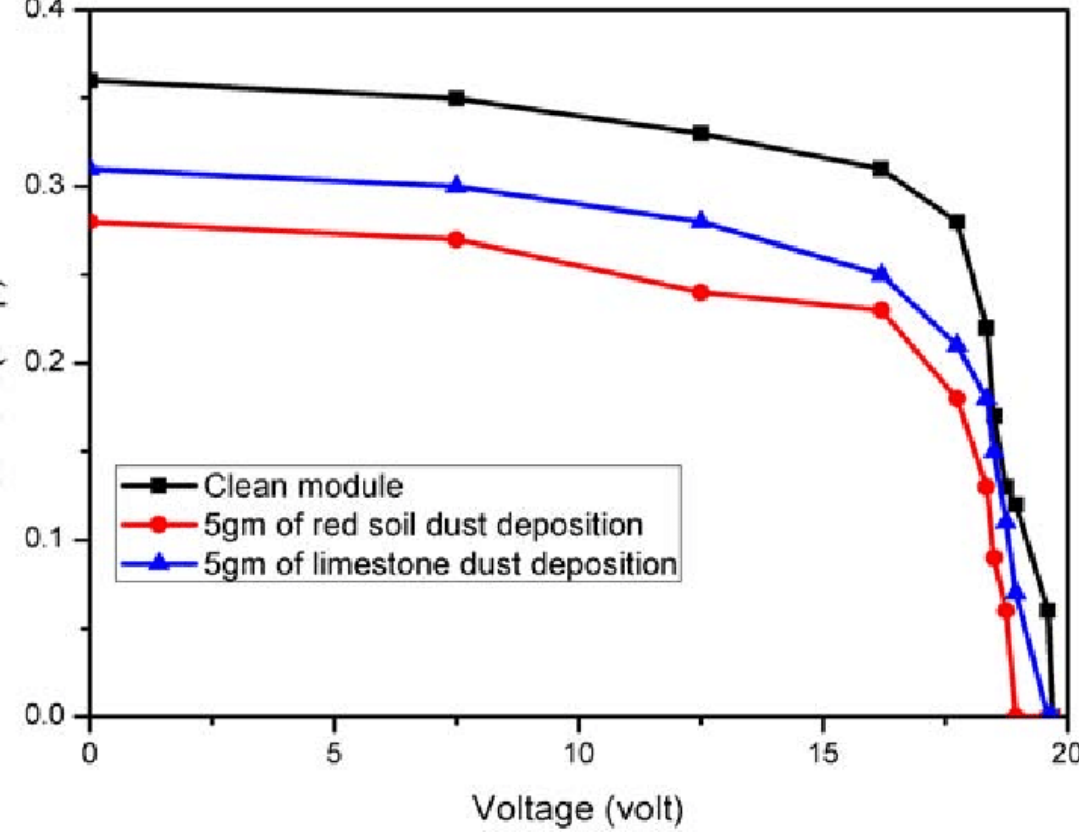
Figure 22. PV panel I-V curve characteristics with respect to dust deposition [115]. Table 7. Summary of the literature that concerns the impact of dust on PV systems.